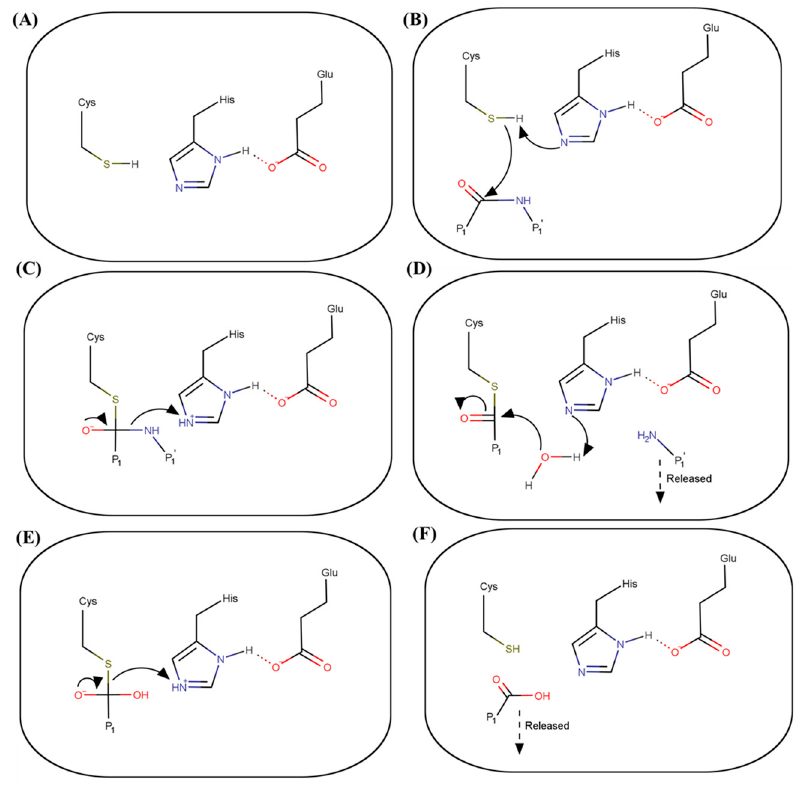
Figure 2. Proteolysis mechanism of HuNoV protease. ( A ) The three residues within the catalytic triad are at the rest state. ( B ) Binding of a substrate induces a conformational change, which leads to the removal of a proton on the thiol side chain of the Cys by the His ring. The active thiol then launches a nucleophilic attack on the carbonyl carbon of the substrate. ( C ) A covalent bond is formed between the substrate and the sulfur and a protease–substrate tetrahedral intermediate is formed. The His ring then donates a proton to the amide nitrogen of the substrate. ( D ) This leads to the breakage of the peptide bond, which releases one side of the substrate out of the active site, as indicated by the dashed arrow. The His ring then activates a water molecule, which launches a nucleophilic attack on the acyl-enzyme complex. ( E ) Attacking from the water molecule forms the second tetrahedral intermediate. The His ring again donates a proton to the intermediate complex. ( F ) The tetrahedral intermediate complex then decomposes. The substrate is released out of the active site. The enzyme is back to the native state. Red indicates an oxygen atom. Blue indicates a nitrogen atom. Green indicates a sulfur atom. Arrow indicates a transfer of an electron. Dashed arrow indicates the releasing of functional group from the active